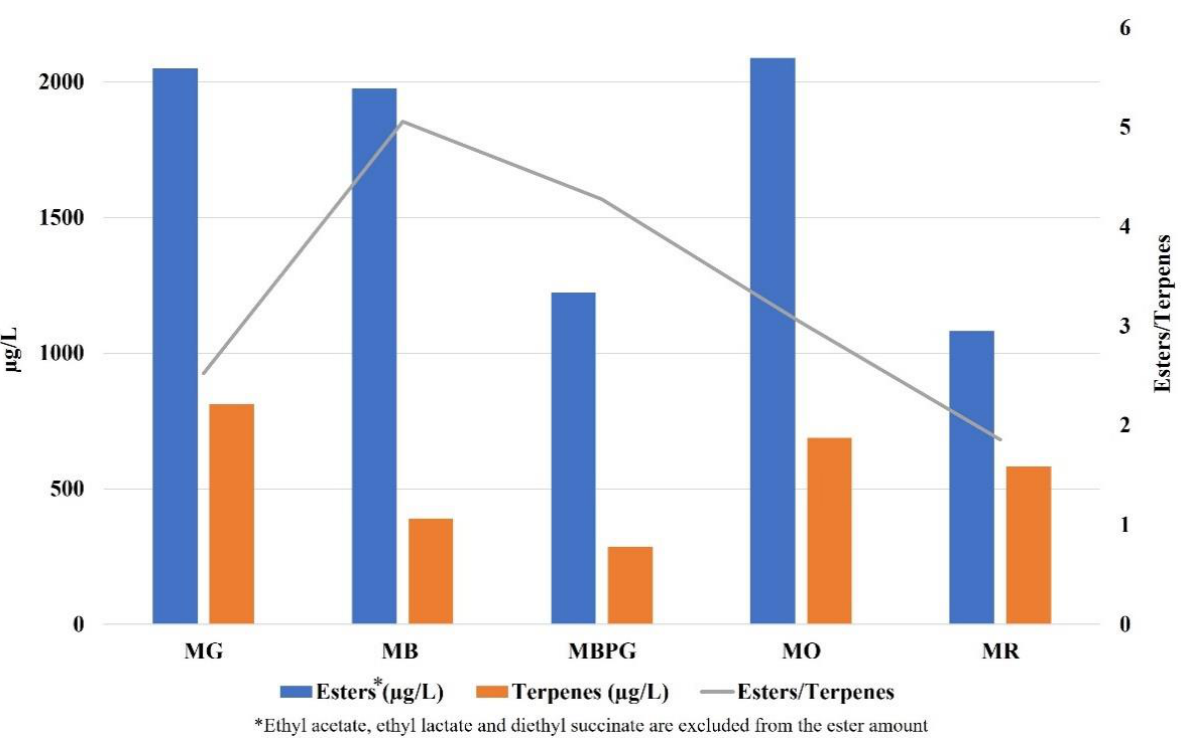
Figure 2. Amount of esters and terpenes, and their ratio in fortified Moscato wines from different varieties. MG = Moscato Giallo; MB = Moscato Bianco; MBPG = Moscato Bianco at Petit Grain; MO = Moscato Ottonel; MR = Moscato Rosa.